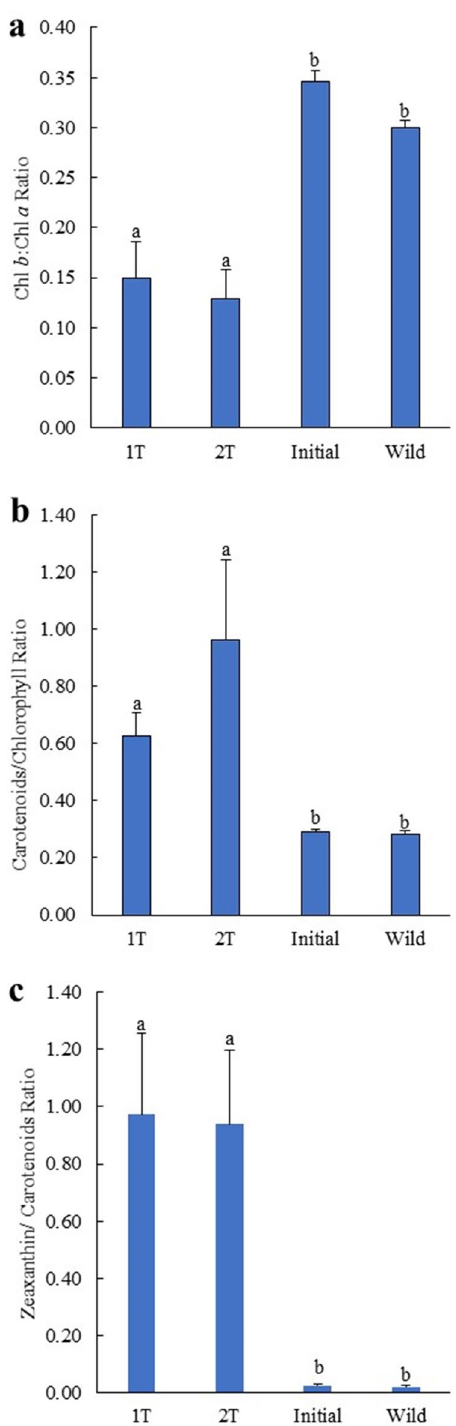
Figure 8. Chlorophyll b :chlorophyll a (Chl b /Chl a ), total carotenoids/chlorophyll and zeaxanthin/carotenoids ratios measured in Salicornia ramosissima cultured in the same tank (1 T) or in two separate tanks (2 T) than polychaetes ( Arenicola marina and Hediste diversicolor ). Average values ± SD (n = 5). Different letters indicate significant differences ( p < 0.05) between